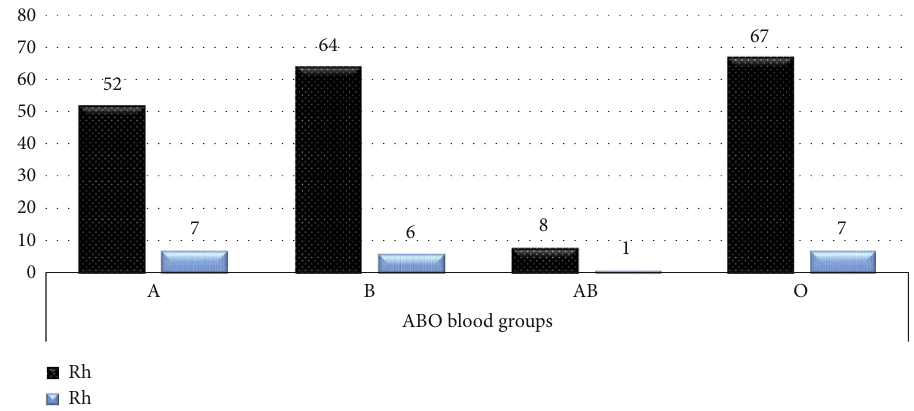
Figure 1: Frequency of the ABO and Rh blood group phenotypes among T2DM patients.